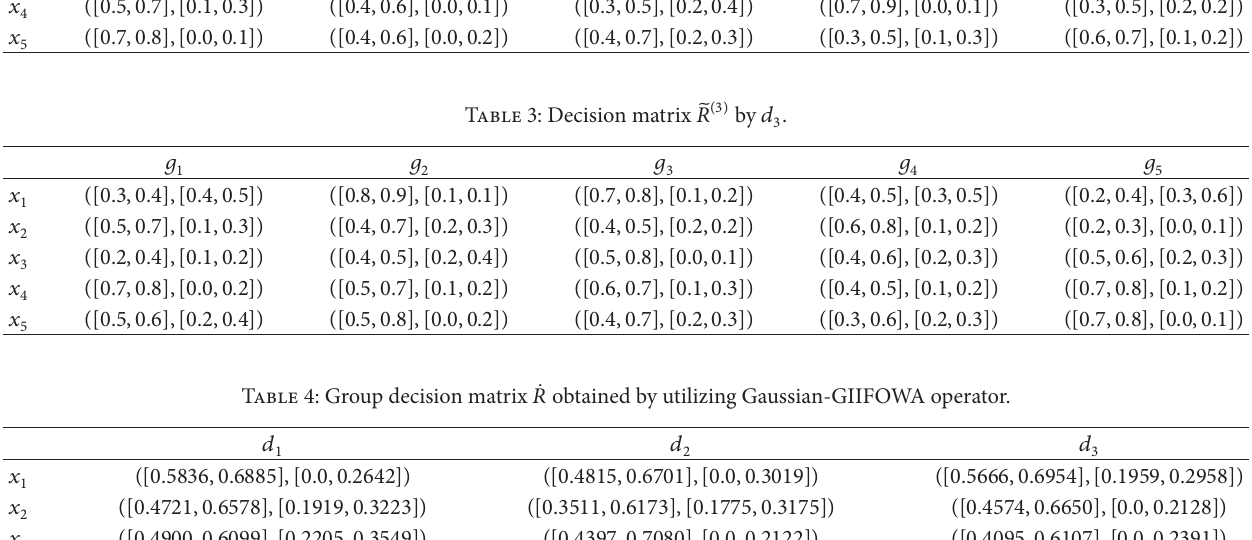
Table 3: Decision matrix